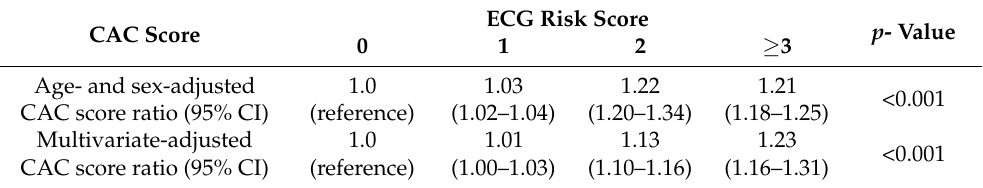
Table 4. CAC score ratio 1 (95% CI) by ECG risk score in 134,802 study